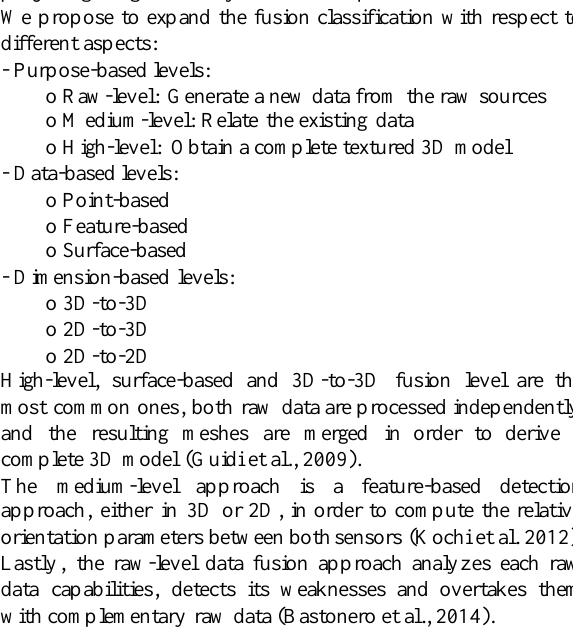
surveying and modeling projects in the CH field.